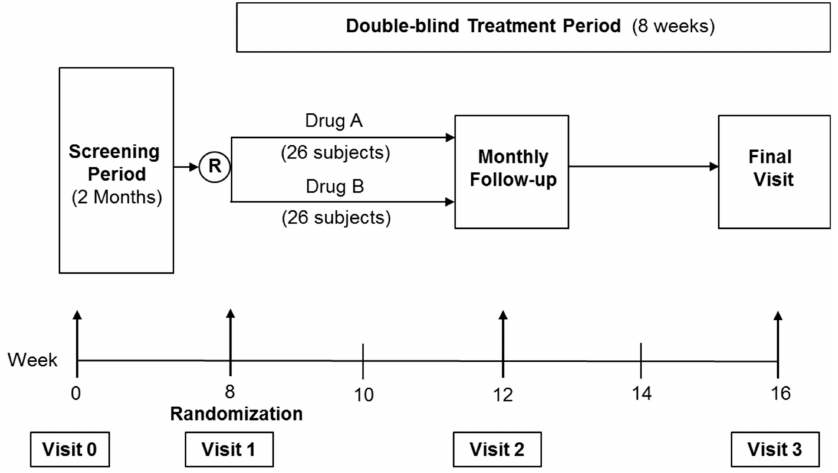
Figure 1. Overall study